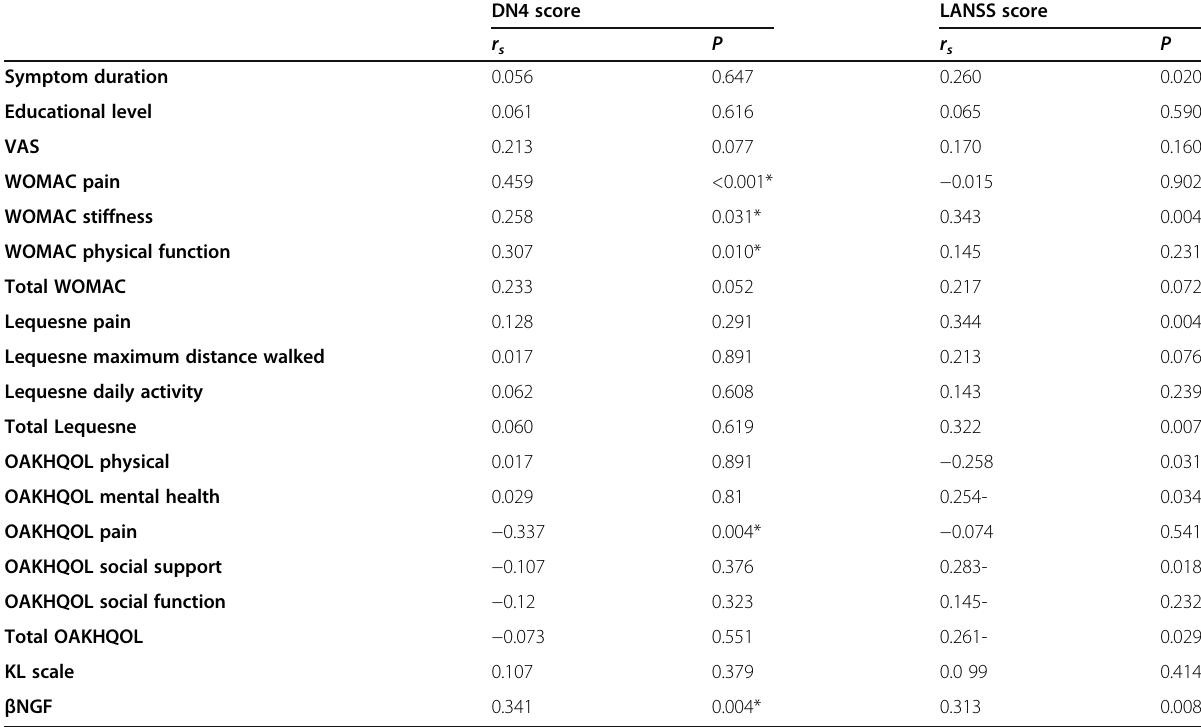
Table 6 Correlations of total DN4 score and LANSS score with the studied